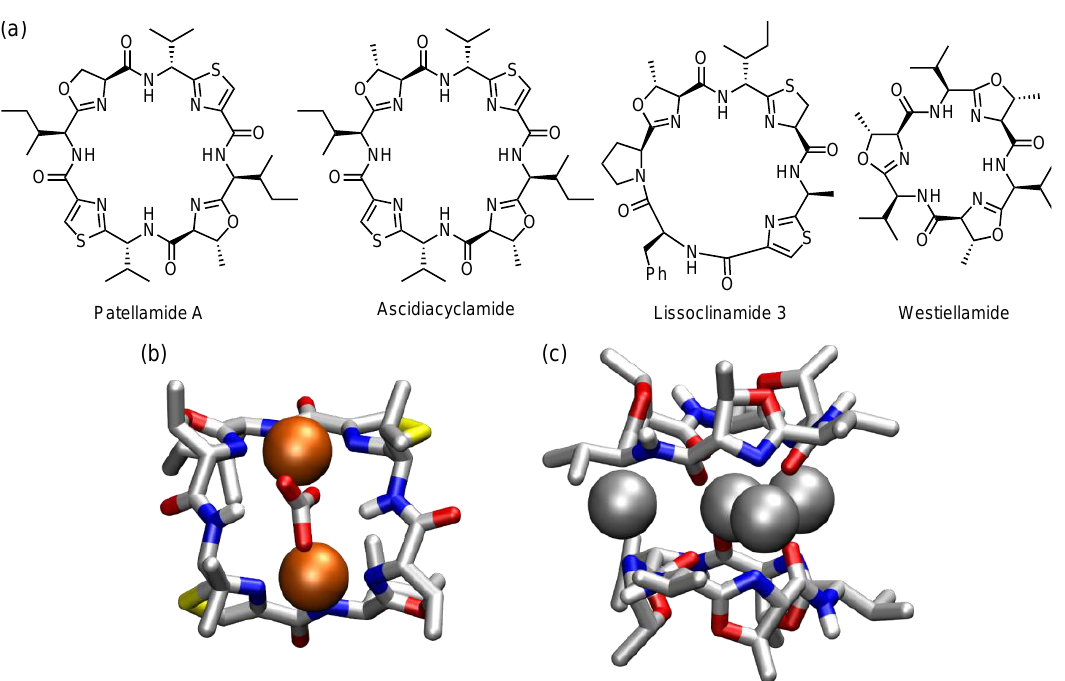
Figure 15. Examples of natural cyclopeptides containing oxazoline, thiazoline, or thiazole residues ( a ), and crystal structures of the dicopper(II) complex of ascidiacyclamide (CSD Entry: POHKOM) ( b ), and the tetrasilver(I) complex of westiellamide (CSD Entry: WICZAJ) ( c ). Solvent molecules, counterions, and protons, except acidic ones, are omitted for reasons of clarity.